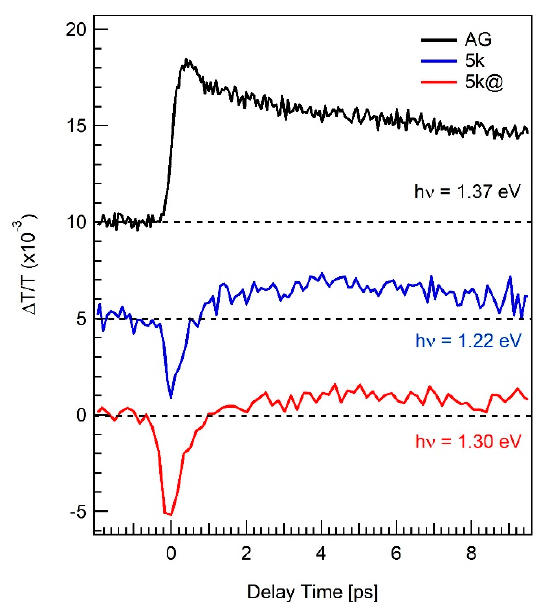
Figure A2. Behavior of the transient transmittance versus the pump and probe delay time collected on the AG (black), the 5k (blue) and the 5k@ (red) samples. Δ T/T profiles are taken at the maximum of the PB band (Figure 4 of the article).